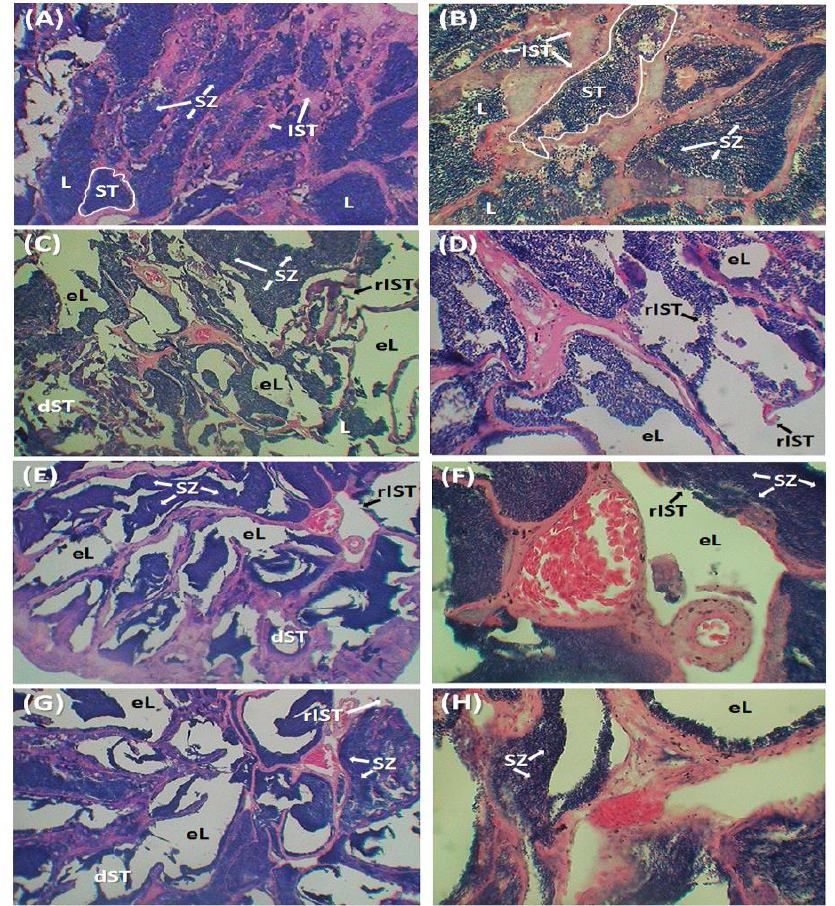
Figure 2. Histological alterations in climbing perch testes exposed to different concentrations of ethinylestradiol (EE2)/desogestrel (DES) mixture. ( A – H ) correspond to 0 ng EE2 plus 0 ng DES, 3 ng EE2 plus 15 ng DES, 30 ng EE2 plus 150 ng DES, and 300 ng EE2 plus 1500 ng DES per liter of water fishes were exposed to, respectively; arrows indicate seminiferous tubules (ST), Sertoli cells (S), increased interstitial area (IIA), broken testicular epithelium (BTE), absent Sertoli cells (ASC), degenerated Sertoli cells (DSC), cysts (CT), and focal loss of spermatocytes (FLS); H – E staining; A , C , E , and G are 10×and B , D , F , and H are 40× magnified. Table 3. Summary of histopathological alterations of climbing perch testes exposed to different con- centrations of ethinylestradiol/desogestrel mixtures.